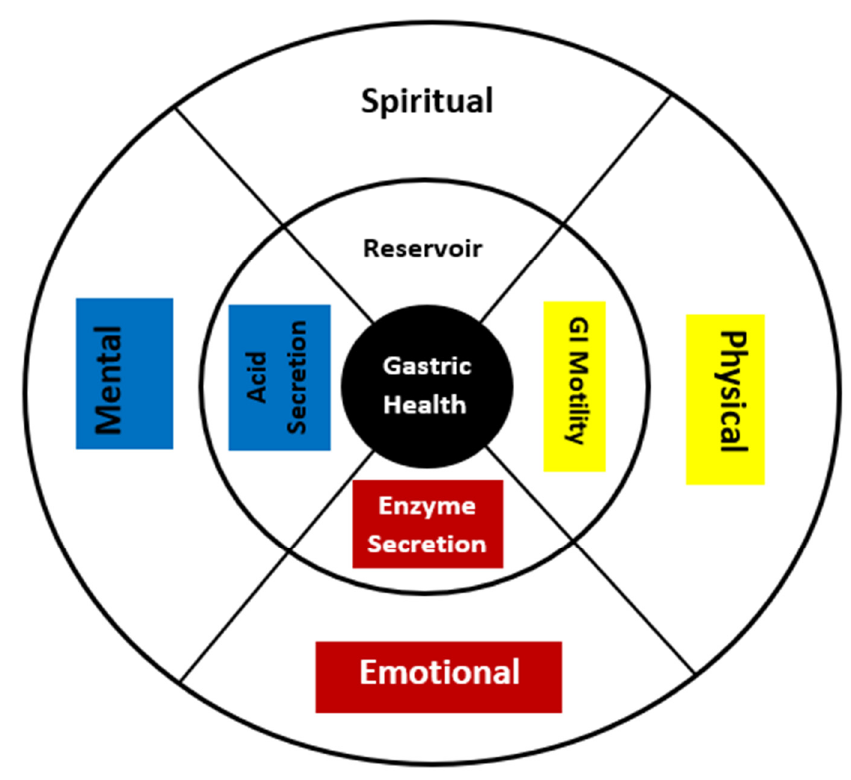
Figure 3. Gastric medicine wheel: combining biology and culture to explain gastric health.